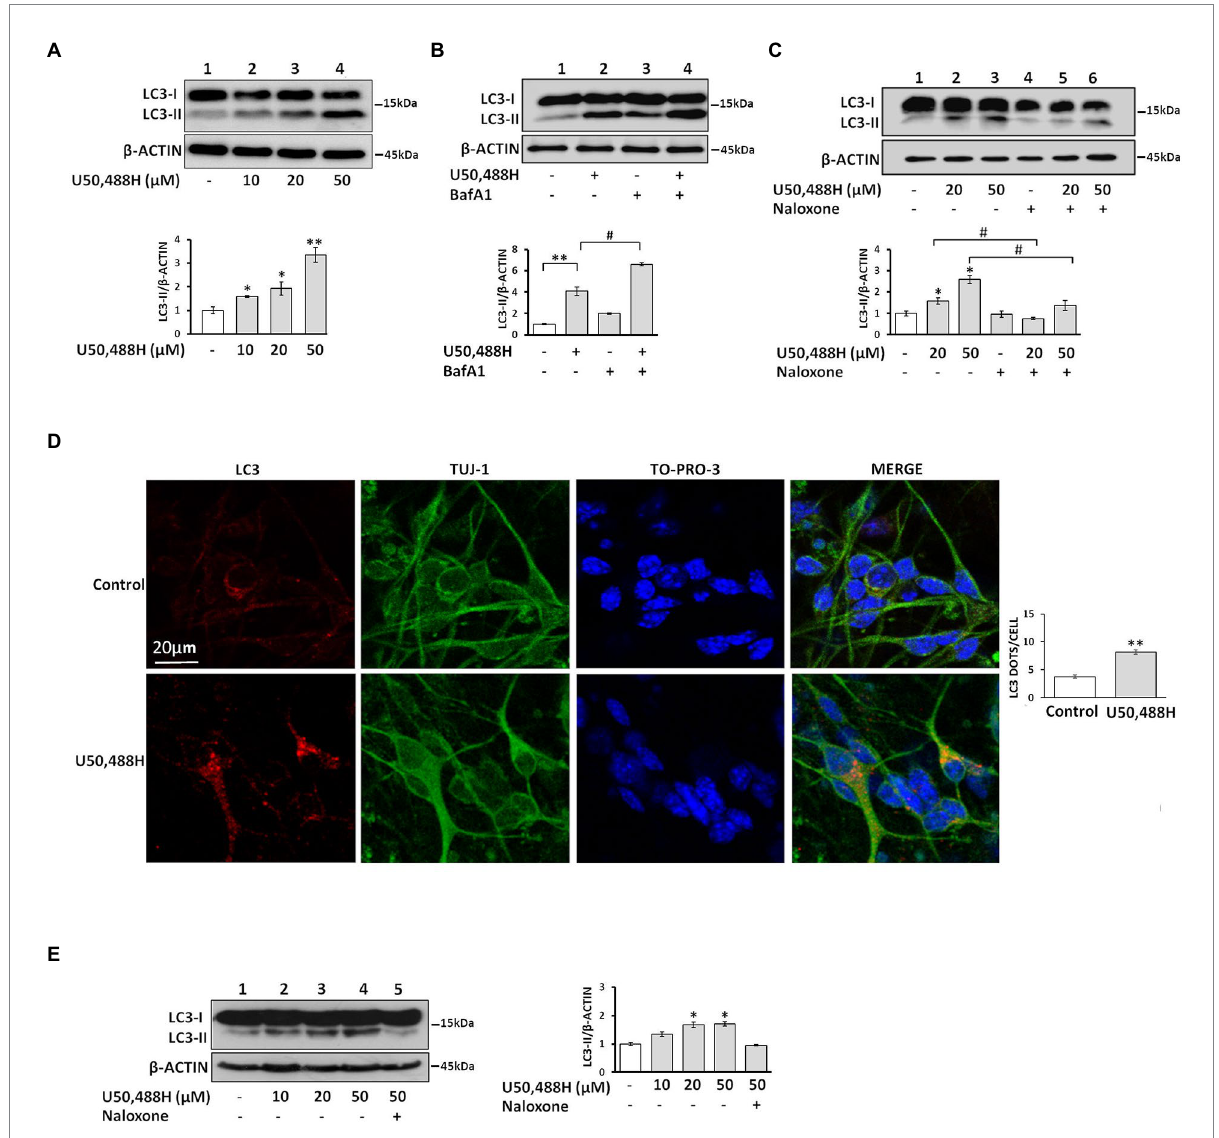
FIGURE 1 Activation of the κ -OR induces the autophagic machinery in neuronal cells. (A) Treatment of κ -Neuro-2A cells with the κ -OR agonist U50,488H results in upregulation of LC3-II in a dose-dependent manner. (B) κ -Neuro-2A cells were pre-treated with 20 nM BafA1 for 16 h, prior to U50,488H (20 μΜ ), or (C) , with 50 μ M naloxone for 45 min, prior to agonist exposure for 6 h. All cell lysates (50 μ g) were subjected to 17% SDS-PAGE for western immunoblotting to detect the autophagosome formation, top panels, immunoblots of LC3-II and β -actin; bottom panels, quantification of LC3-II (measured with an anti-LC3B antibody and normalized to β -actin levels). (D) Primary hippocampal cultures were exposed to U50,488H (20 μΜ ) for 6 h. Confocal images of 10 DIV embryonic hippocampal neurons, immunostained with an anti-LC3B antibody (1:200) to label autophagosomes, Tuj-1 (1:1000) to label dendrites, and the nuclear dye TO-PRO-3 (1:500). (E) LC3-II is up-regulated dose dependently upon U50,488H exposure (6 h) in embryonic primary neuronal cultures (lanes 2–4). Lane 5, represents lysates of neuronal cultures treated with 50 μΜ naloxone prior to U50,488H administration. Top panel represents immunoblots of LC3-II and β -actin. Quantification of LC3-II was normalized to β -actin levels. All experiments were performed independently at least 3 times. Error bars represent mean values ± SEM. Statistical analysis was performed using one or two-way ANOVA. * p < 0.05 and ** p < 0.01 as compared in the absence of agonist, # p < 0.05 as compared with samples in the presence of